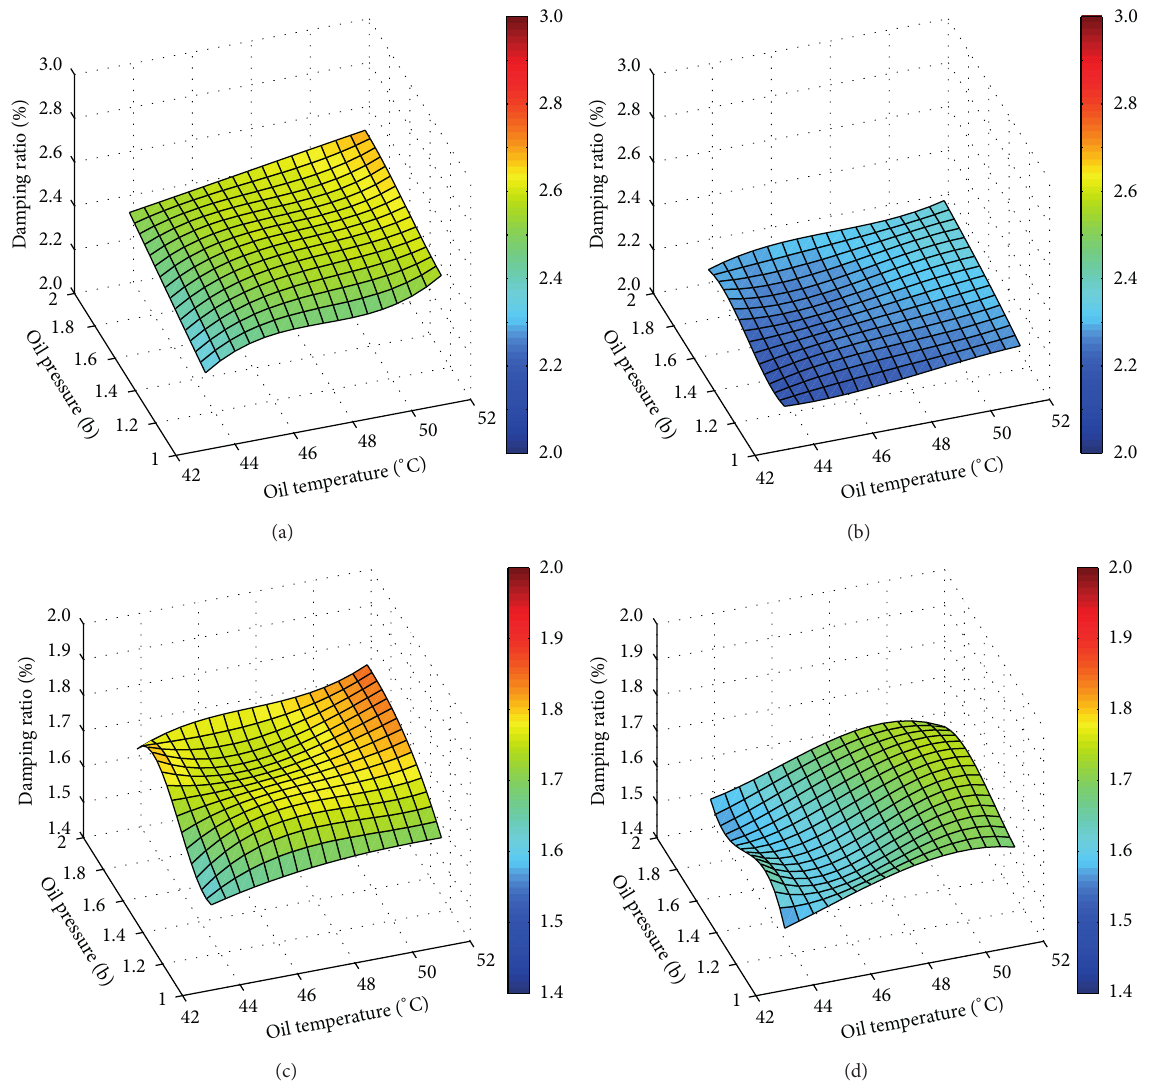
Figure 19: Combination effect of oil inlet and pressure on the stability of